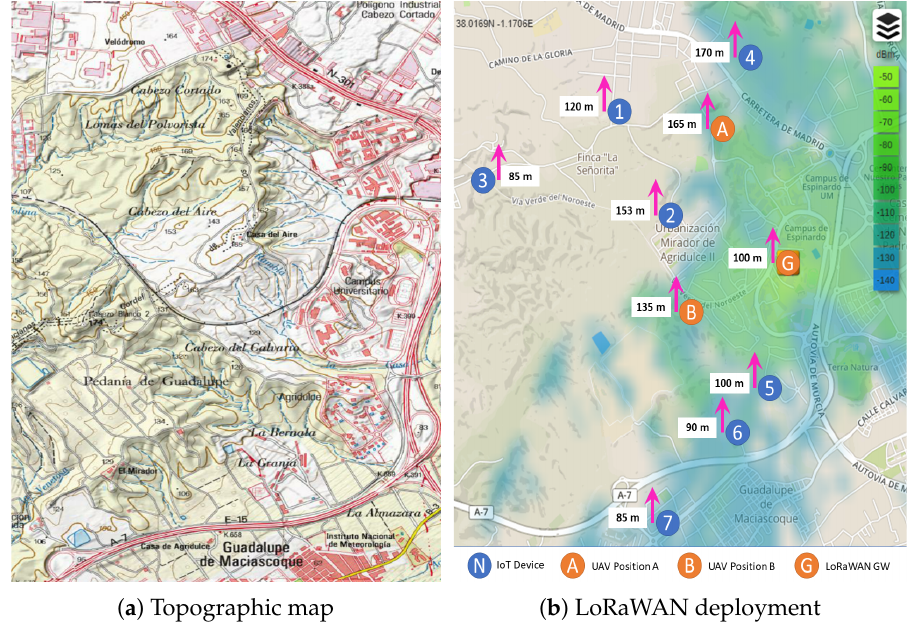
Figure 3. Maps of region under study, Espinardo Campus, University of Murcia (Spain).